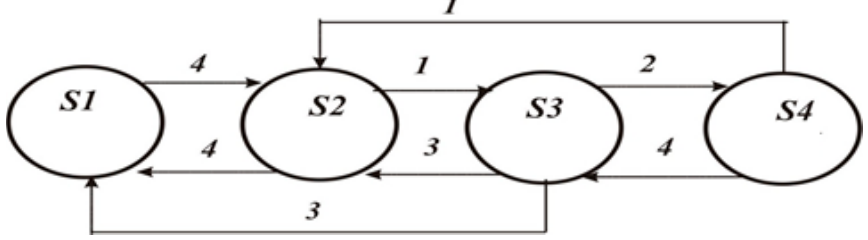
Figure 3. Graph of states of development sanatoriums and resort complexes in Truskavets.